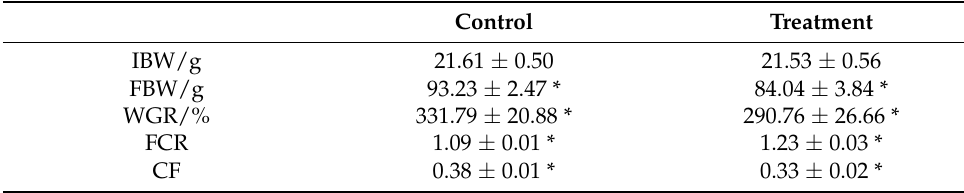
Table 3. Comparison of growth performance in A. schrenckii .